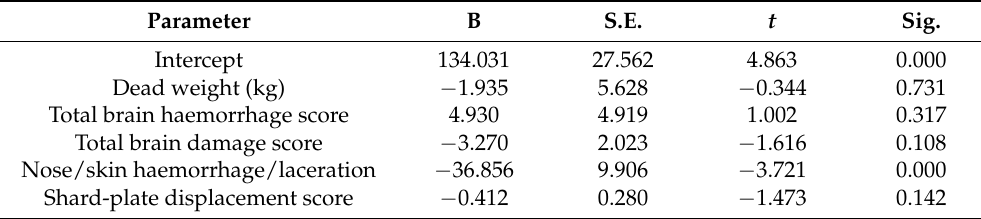
Parameter estimates from the general linear model (GLM) testing for an effect of dead weight (kg), brain haemorrhage score, macroscopic brain damage score, and nose/skin haemorrhaging/laceration on time to loss of